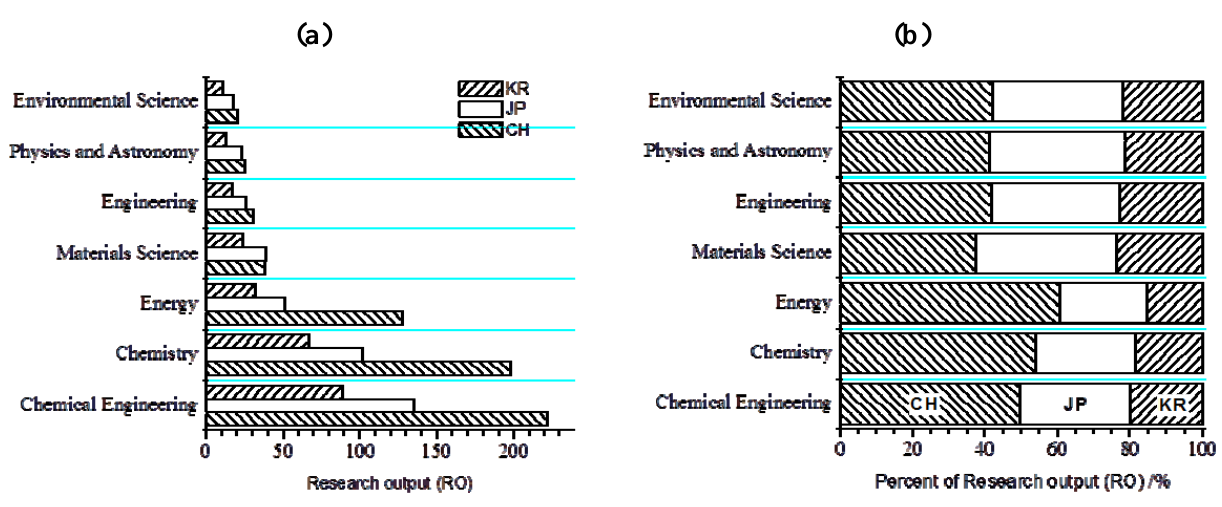
Figure 4. Growth in the number of papers for selected subjects (chemical engineering and energy-related